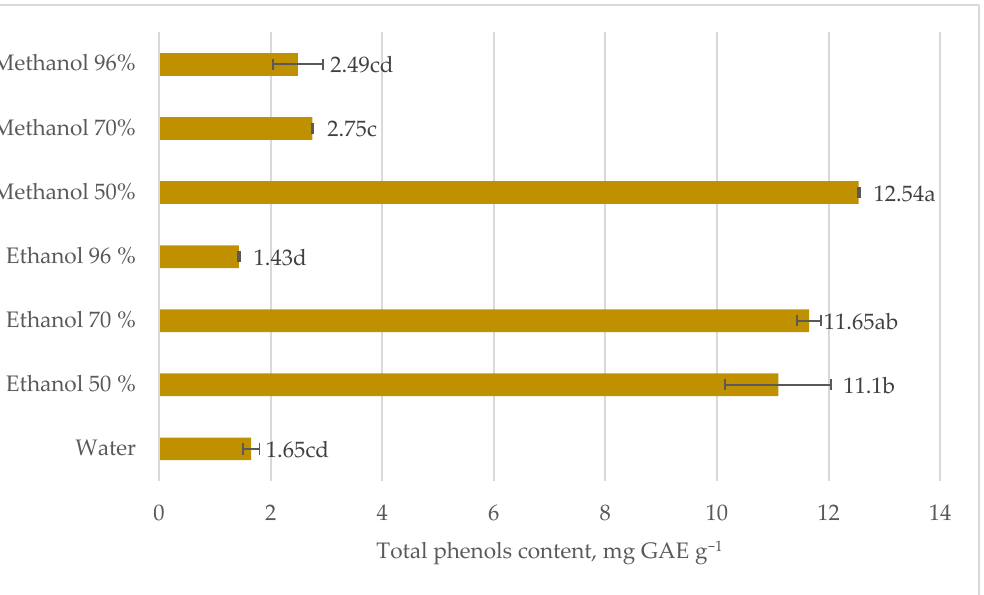
Figure 2. Total phenols content in stinging nettle ( Urtica dioica L.) roots extracts, mg GAE g − 1 DM . According to the results, the total flavonoid content in the nettle leaves extracts was the highest at 96% methanol while the least at 50% methanol. In terms of ethanol, the most effective were 96 and 70% extracts (Figure 3). Water extraction was characterized by higher efficiency than 70 and 50% methanol and 50% ethanol. According to the results, almost all extracted phenols in 96% methanol were composed of flavonoids. Vajic et al. [20] reported that 50% methanol was the most efficient for stinging nettle phenols extraction, but in our research, it was four times less effective than 96% methanol. This may be due to the maceration time and solid-to-liquid ratio. In our study maceration time was prolonged while the solid–liquid ratio was 1.5 times higher (Figure 3). The total flavonoid content in stinging nettle roots was comparatively lower than in leaves (Figure 4). The highest total flavonoid content was observed in 50% ethanol extract while the least in 96% ethanol. The total flavonoid content in water, 70% ethanol, and 96% methanol was not significantly different. According to Vajic et al. [20], predominant phenol in nettle leaves was rutin, but Jeszka-Skowron et al. [32] research results showed that the lowest content of 3-caffeoylquinic acid or rutin was determined in nettle roots comparing with aerial parts of the plant. In general, the preference of the phenols for methanol and ethanol may be caused by their non-polar part and the aliphatic fragment of alcohols. The bigger molecules prefer ethanol, as it could better “cover” the gaps between the hydrogen bonds while smaller- non-polar solvents,. Extraction yield is enhanced with the increase in the medium polarity [33]. According to Do et al. [34], the extraction yield of phenols from Limnophila aromatica was higher in pure methanol than in pure ethanol and pure acetone. This showed that the extraction yield increases with the increasing polarity of the solvent used in